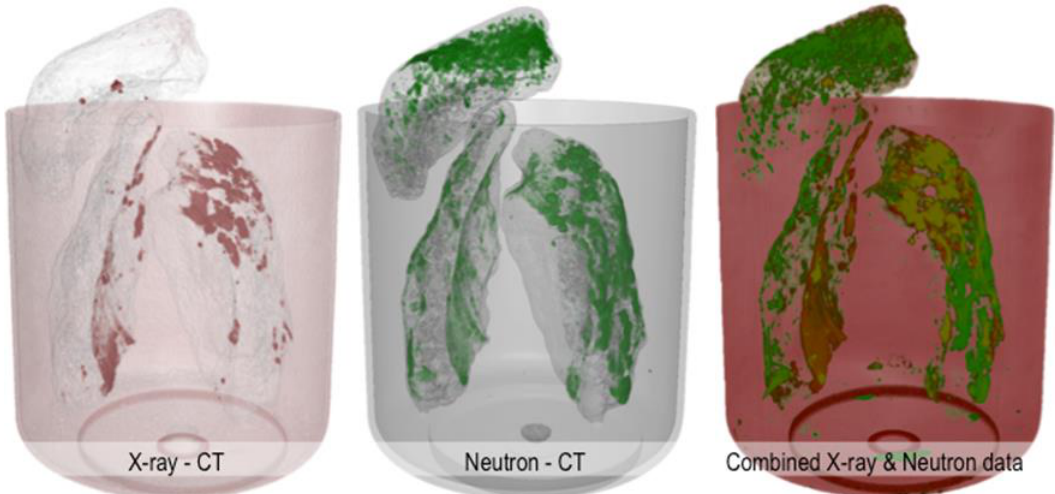
Figure 8. Results of tomography studies with neutrons and X-rays of the ceramic samples from Augusta Raurica containing both metallic and organic remains at different positions of the samples: above—virtual slices; below—3D view on the material distribution.